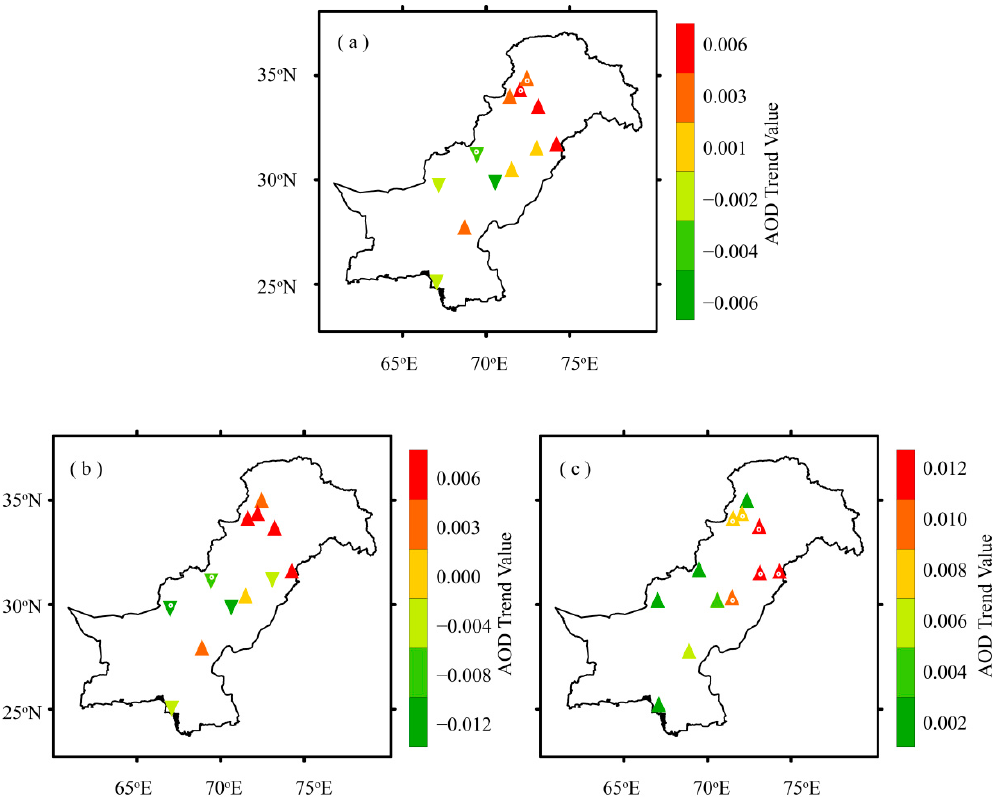
Figure 5. Distribution of annual and seasonal means AOD trends (in units/year) over the study area during 2003–2017, ( a ) Annual, ( b ) Summer, ( c ) Winter, based on AOD data acquired from MODIS-Terra DB product. The points with central white dots represent statistically significant AOD trends over the selected regions. Magnitudes of trends are listed in table 2.